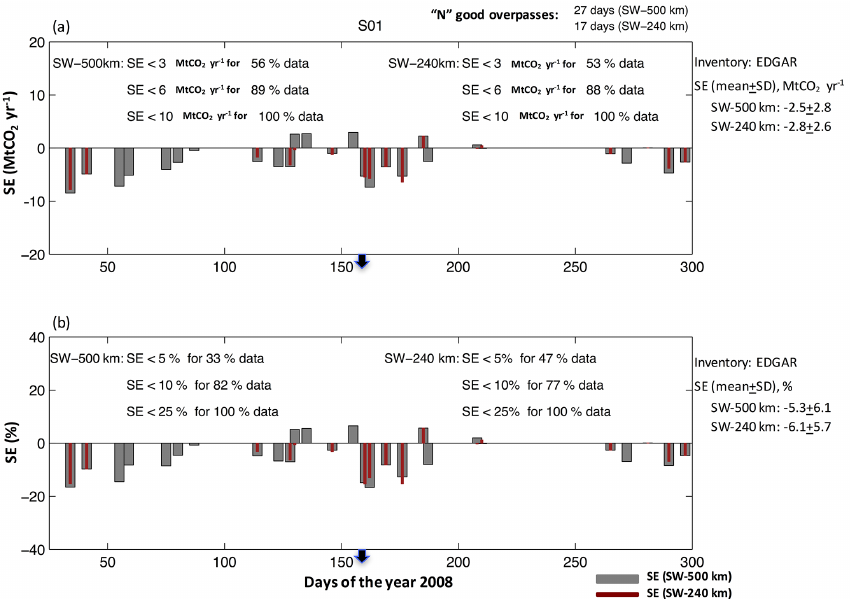
Figure 9. Systematic errors of the retrieved emission fluxes for S01, obtained by the inverse optimization using 1 year of CarbonSat simulated observations. Results of two different swath widths (SW) – 500km (grey) and 240km (red) – are shown. Panels (a) and (b) show SE in MtCO 2 yr − 1 and in percent, respectively. An overview of the statistical distribution of SE, separately for 500km (grey) and 240km (red) swath widths, is given inside the panel. The overall mean ± standard deviation is given outside the respective panels.